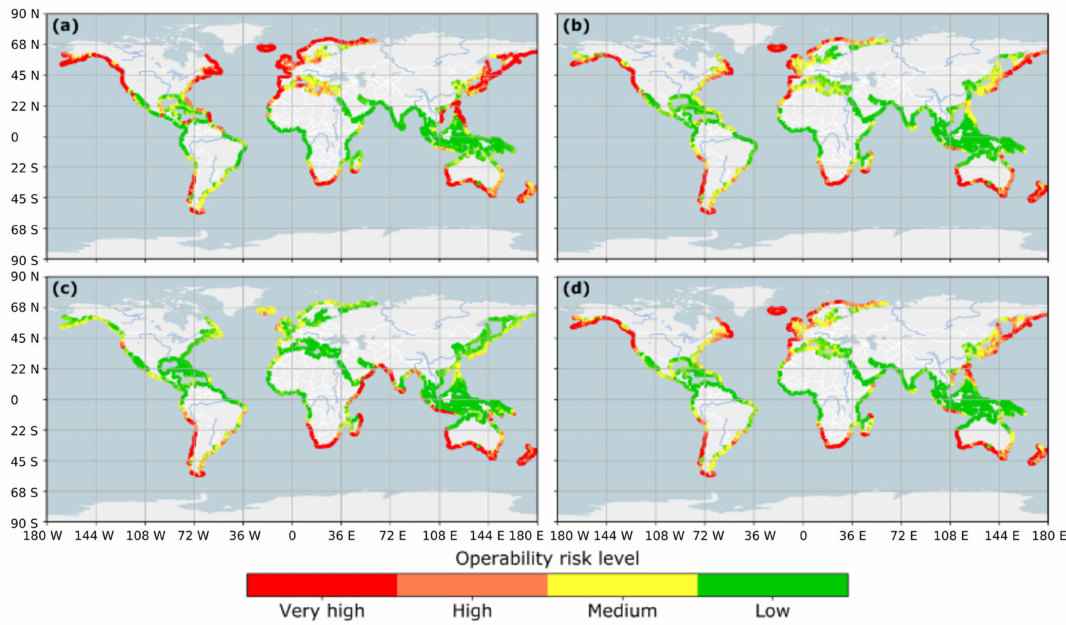
Figure 7. Geographical overview on port operability risk for four separate seasons: ( a ) DJF; ( b ) MAM; ( c ) JJA; ( d ) SON.